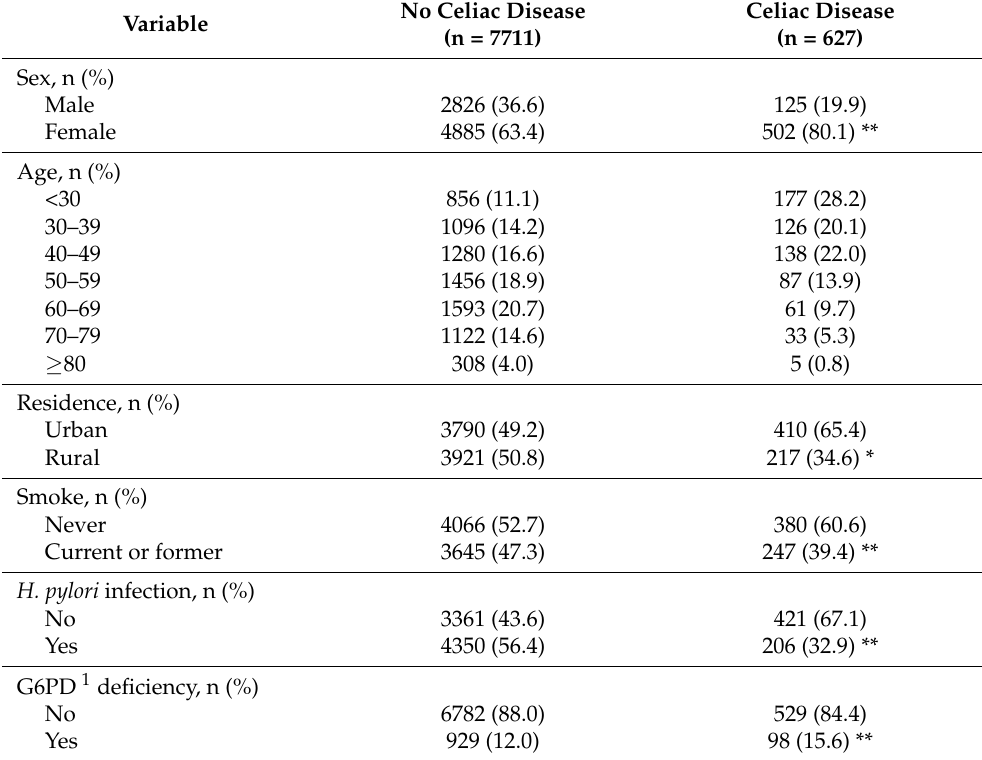
Table 1. Descriptive statistics in 8338 study participants according to celiac